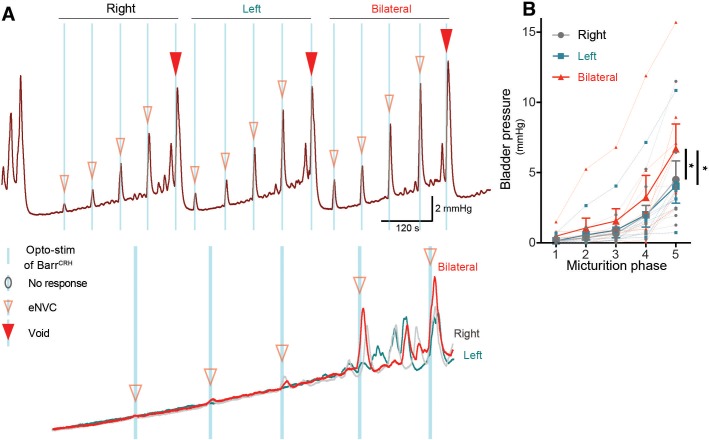
Dynamics of bilateral BarrCRH evoked events through the micturition cycle.(A) Comparison of unilateral with bilateral opto-activation of BarrCRH neurons during continuous filling cystometry showing the graded increase in eNVC amplitude with phase of the micturition cycle and the augmented response to bilateral stimulation. (B) Bilateral stimulation evoked larger eNVC, an effect that is more pronounced later in the micturition cycle (n = 7 mice). (* - p<0.05, Related samples Friedman's two way-ANOVA by ranks.). Source data in Figure 5—figure supplement 1—source data 1.Figure 5—figure supplement 1—source data 1.Data for 'Dynamics of BarrCRH evoked events through the micturition cycle, supplement 1'.